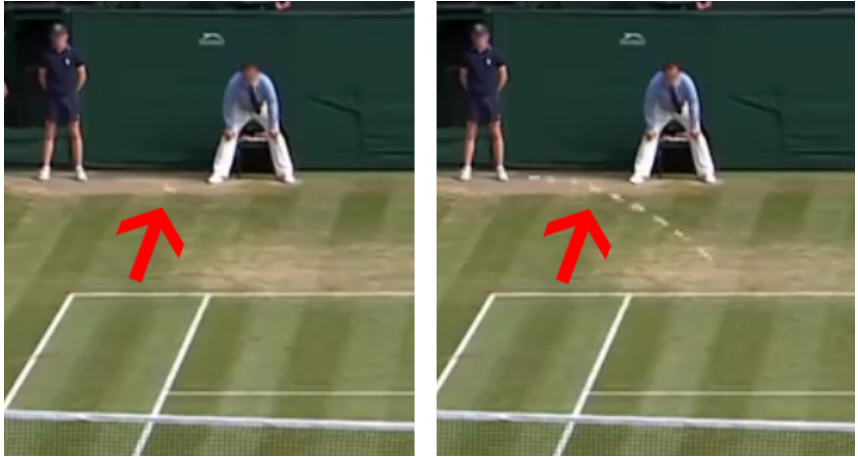
Figure 2. The ( left ) image shows a single frame as it is extracted from the video. The tennis ball is indicated by the red arrow and is almost undistinguishable. The ( right ) image overlays the position of the tennis ball in the previous and following frames and shows how the motion information is foundamental for its